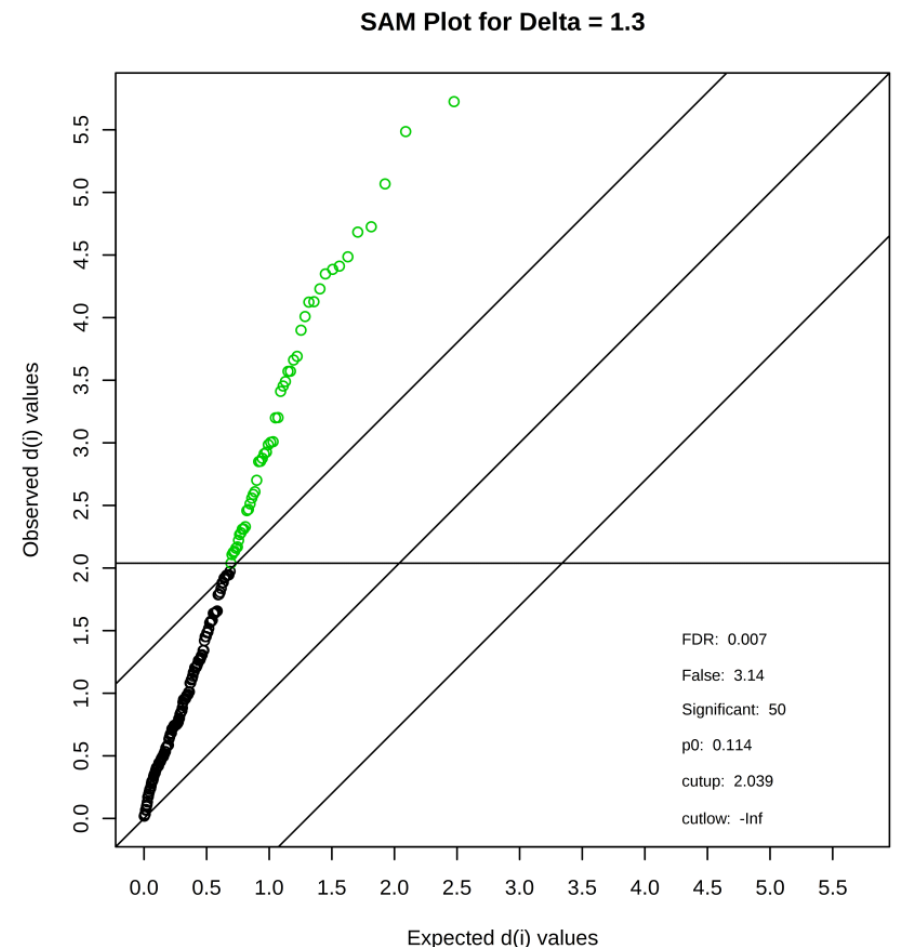
Figure 2. Identification of metabolites with significant changes in expression by significance analysis of microarray (SAM) among the three groups. The SAM plot is a scatter plot of the observed relative difference versus the expected relative difference. The solid diagonal line indicates where these two measures are the same. The dotted lines are drawn at a distance of delta from the solid line. The significant variables are highlighted in green and the details are shown in Table 1. Table 1. Significant features identified by SAM.